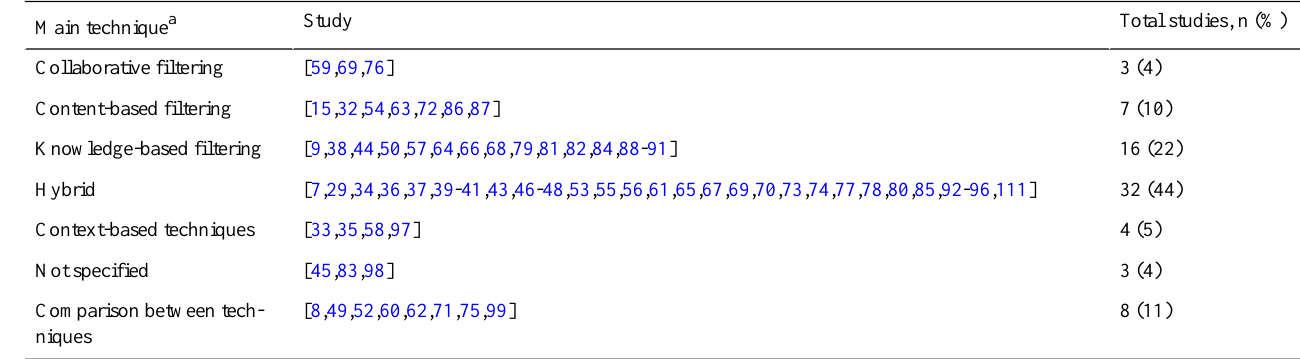
Table 2. Overview of the different recommender techniques used in the